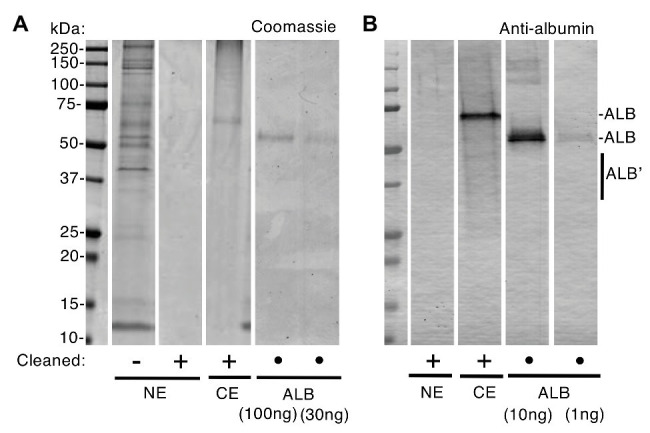
Albumin is absent from normal enamel after surface-cleaning. Clinically normal enamel (NE) was harvested from a 6-year molar before and after surface-cleaning as indicated (• = not applicable), then subjected to sodium dodecyl sulfate-polyacrylamide gel electrophoresis (SDS-PAGE) and albumin-immunoblotting with peroxidase detection as described under “Materials and Methods” section. Chalky enamel (CE) from an intact opacity on the same tooth, and fresh serum albumin (ALB), were processed in parallel. Equal amounts of NE (equivalent to CE) were loaded in (A) and (B). (A) Coomassie Blue staining revealed numerous protein bands in normal enamel that had not been surface-cleaned, yet no proteins were detectable after surface-cleaning. In contrast, chalky enamel contained a single major band after surface-cleaning (identified as albumin, in B). The ALB standards verified linearity of detection with a sensitivity of about 30 ng. (B) Immunoblotting verified an absence of albumin in cleaned normal enamel, at 1 ng sensitivity (i.e., 30-fold higher than in A). Note that, in addition to the major albumin bands, fragmented albumin species (ALB’) were visible in chalky enamel. This figure was composited from (A) two Coomassie-stained gels, and (B) an immunoblot, made in parallel from one gel in (A).